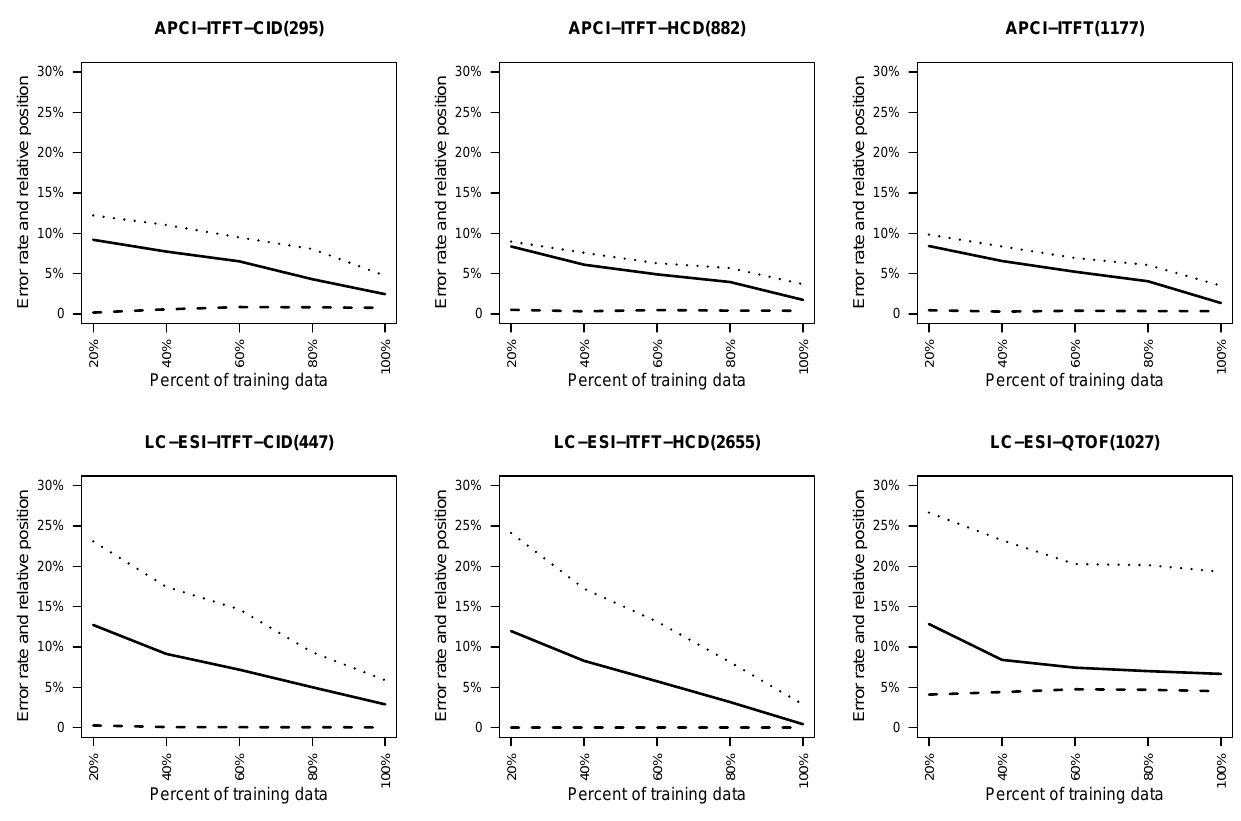
Figure 4. This figure shows for different size subsamples the average cross-validation test error (solid lines) and training error (dashed lines) over all fingerprints, and the average relative rank (dotted lines) of the correct molecule in the list of retrieved